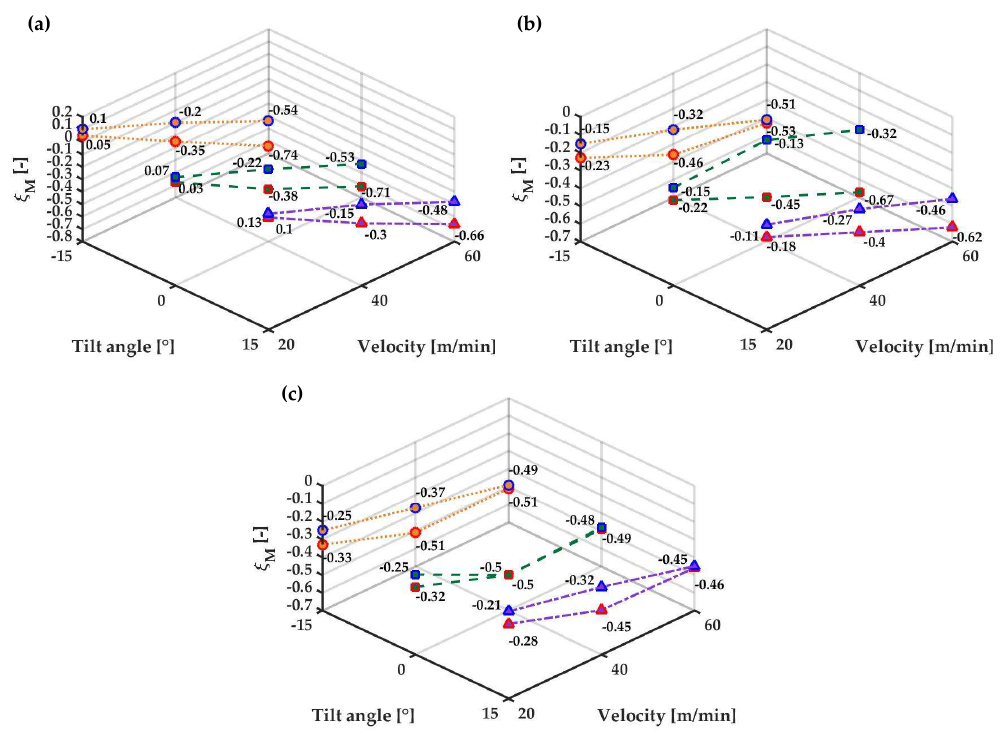
Figure 11. Mass sealing effectiveness coefficient at section δ for AC mass flow ( a ) 3%; ( b ) 5%; ( c ) 7%.